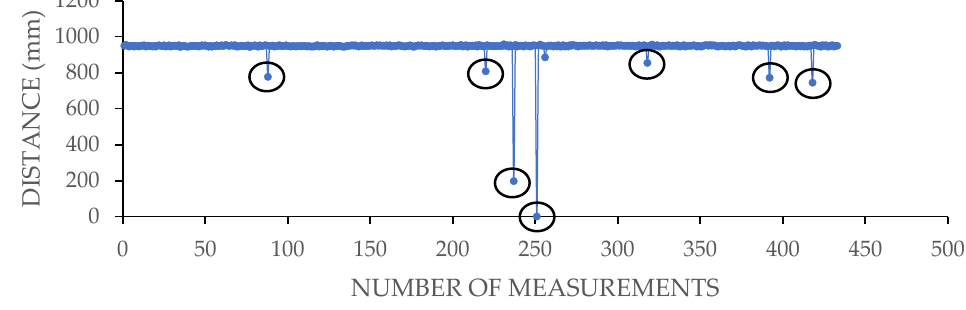
Figure 8. Excluding the outliers of HC-SR04 estimations.